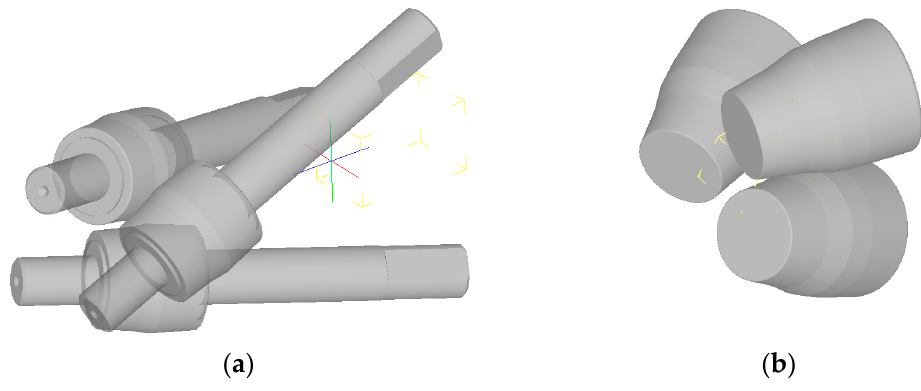
Figure 2. Models of radial shear rolling mills: ( a ) RSP-14/40 mill; ( b ) RSP-10/30 mill. The initial billet with a diameter of 37 mm and a length of 150 mm was rolled on both mills with accelerated reduction. The rolling route was as follows: 37-36.5-34-32-30-28-26- 23-20 mm on the first mill and 20-17-13 mm on the second mill.